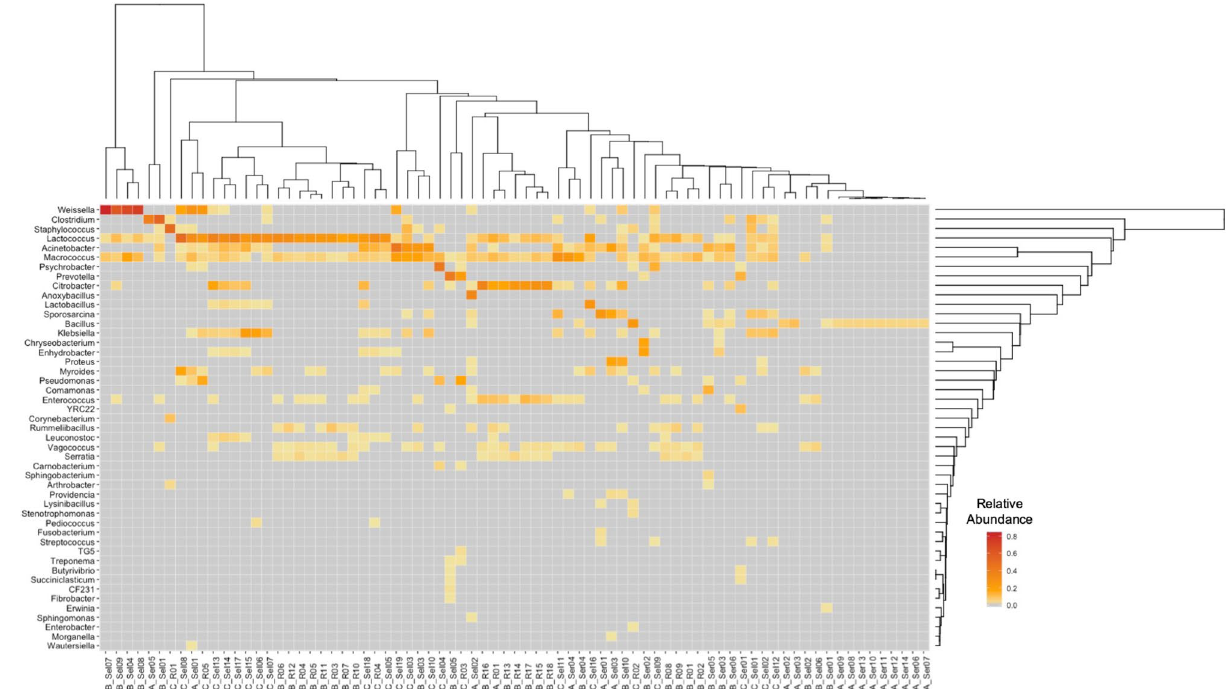
Figure 5. Heatmap of the genus-level relative abundance in the samples positive for one of the three pathogens. The heatmap shows the relative abundance for any genus present at > 1%. The color ranges from pale yellow (low abundance) to dark orange (high abundance). Hierarchical clustering was performed for both the samples and the genera. The samples are labeled with the first letter representing the pathogen (A— B. anthracis , B— Brucella , C— Coxiella ) and the ending representing the regions (R—Ruaha, Sel—Selous,